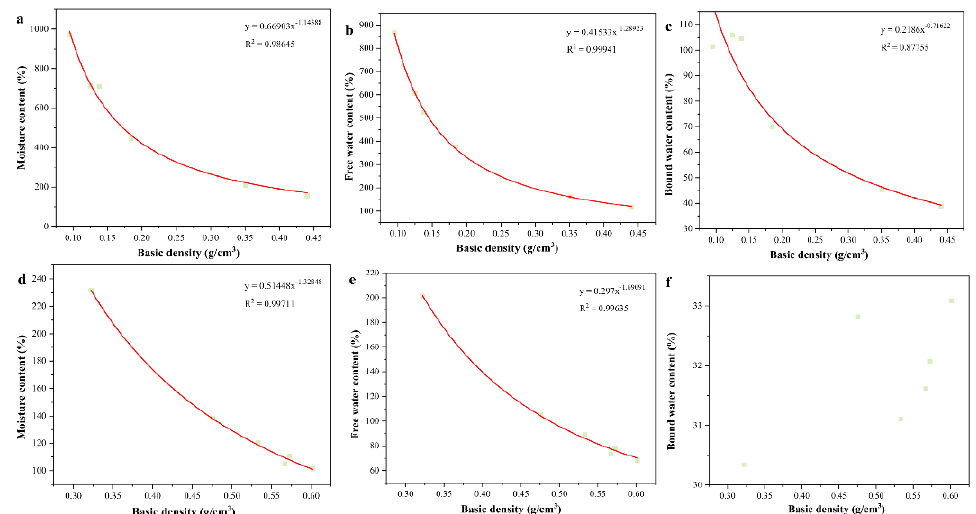
Figure 9. The relationship between the content of different types of moisture and the basic density (( a )–( c ), waterlogged archaeological wood; ( d )–( f ), modern wood). Note: the values in the figure are the average values of three experimental tests and calculations.